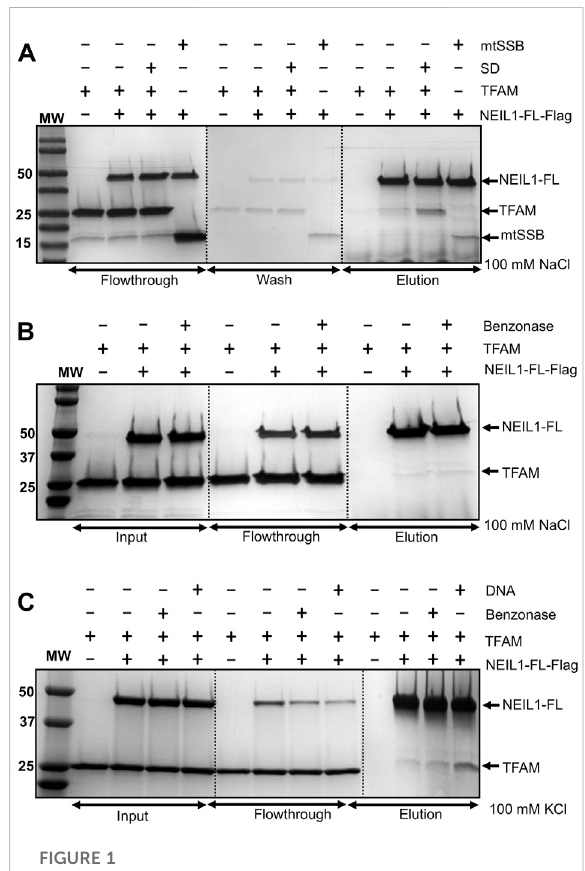
FIGURE 1 Af fi nitypull-downexperimentsrevealaninteractionbetween recombinantly puri fi ed NEIL1 and TFAM. (A) Flag-tagged, full- length NEIL1 (NEIL1-FL) was used to pull down TFAM in the presence and absence of a speci fi c DNA (SD) sequence containing an abasic site in a buffer containing 100 mM NaCl. TFAM was observed in the elution fractions in both the presence and absence of SD. mtSSB was used as a positive control as we previouslydocumentedtheinteractionbetweenNEIL1andmtSSB. (B) The puri fi ed proteins were treated with Benzonase prior to complex formation to eliminate nucleic acid contamination followed by the pull-down experiment. TFAM was observed in elution fractions containing either 100 mM NaCl in the buffer, or 100 mM KCl in the buffer (C) in the both Benzonase treated or non-treated samples indicating that there is a direct interaction between the two